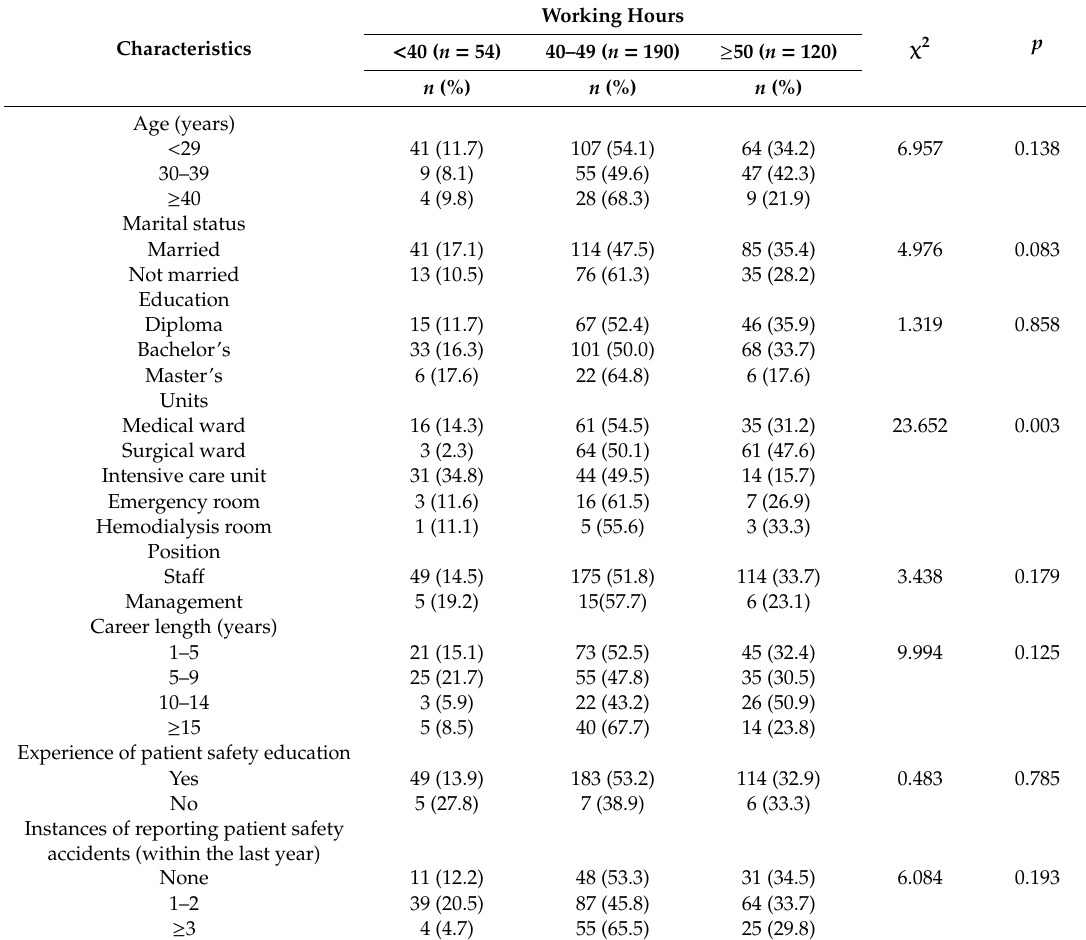
Table 1. Participants’ characteristics by working hour group ( N = 364).